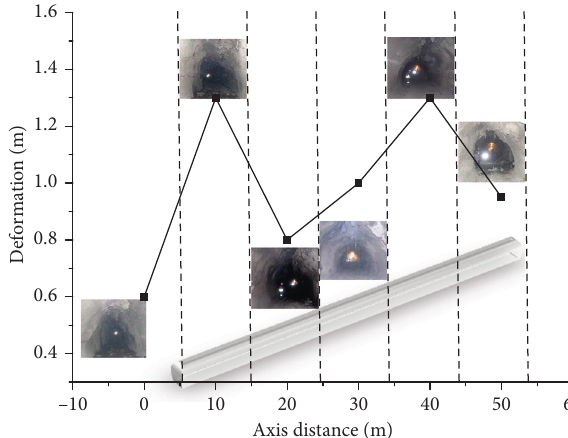
Figure 2: Convergence deformation along the axis section of the